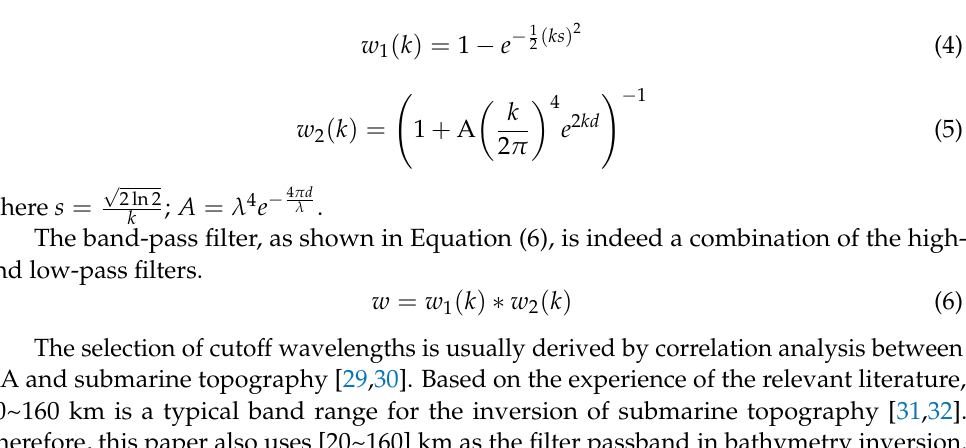
Figure 1. Data processing flow chart for bathymetry inversion. The filters mentioned in the above process were designed as described in [28]. The high- and low-pass filters are defined in Equations (4) and